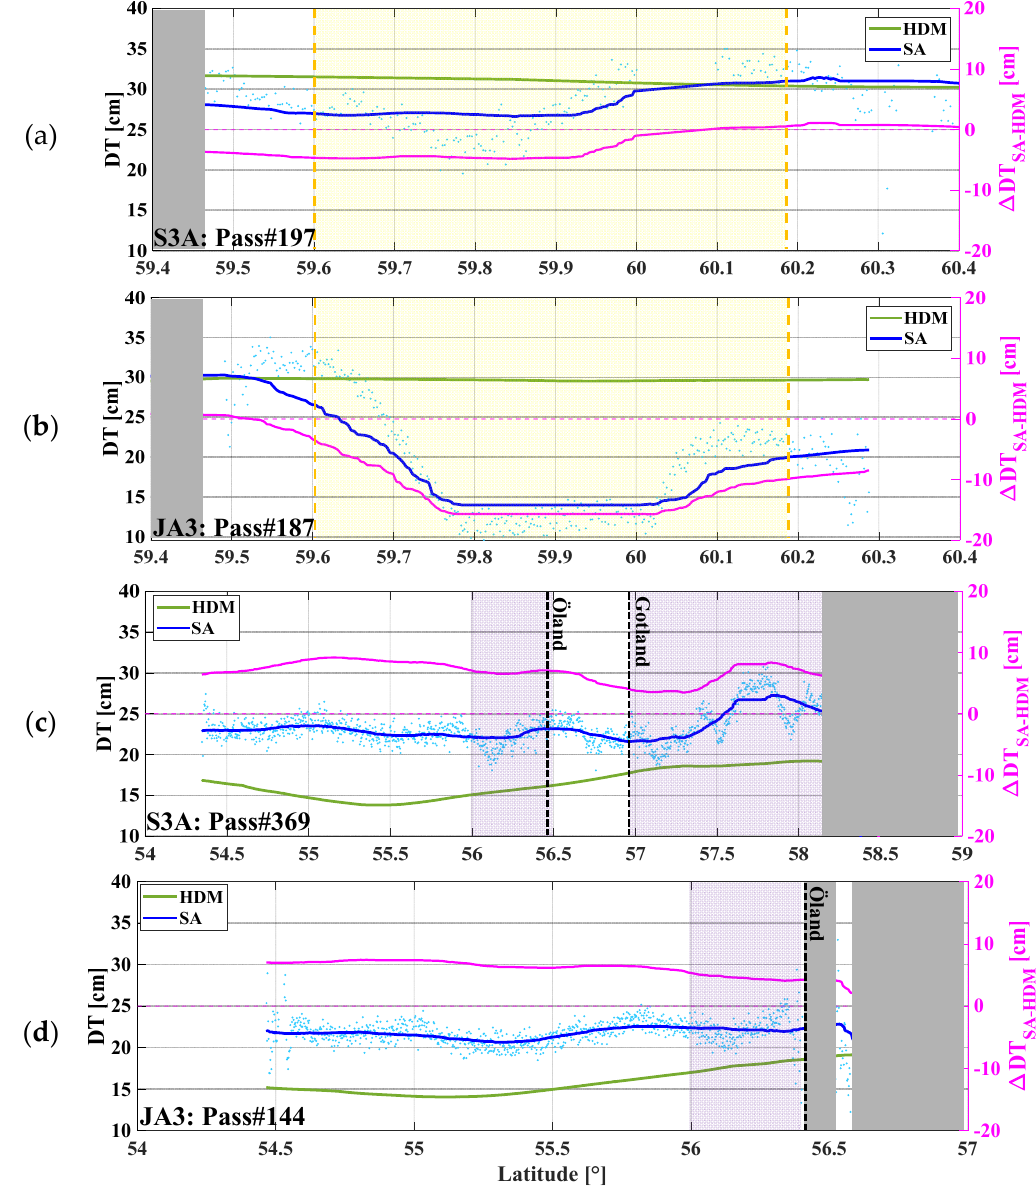
Figure 15. Along-track DT and Mean SA − HDM (Equation (10)) of four selected passes (cf., Figure 14). The along-track mean DT of SA is denoted in blue dots (whereas the blue solid line is the moving median of 0.5 ◦ latitude window) and HDM in green line (left axis). The MEAN SA − HDM is represented on the right axis by magenta color ( a , c ) for two S3A passes at almost the same locations as two JA3 passes ( b , d ). The problematic areas of possible geoid modeling are highlighted in yellow; the purple areas are due to poor quality of SA data near the land (vertical dashed lines represent the locations of islands). The grey zones mask land areas.